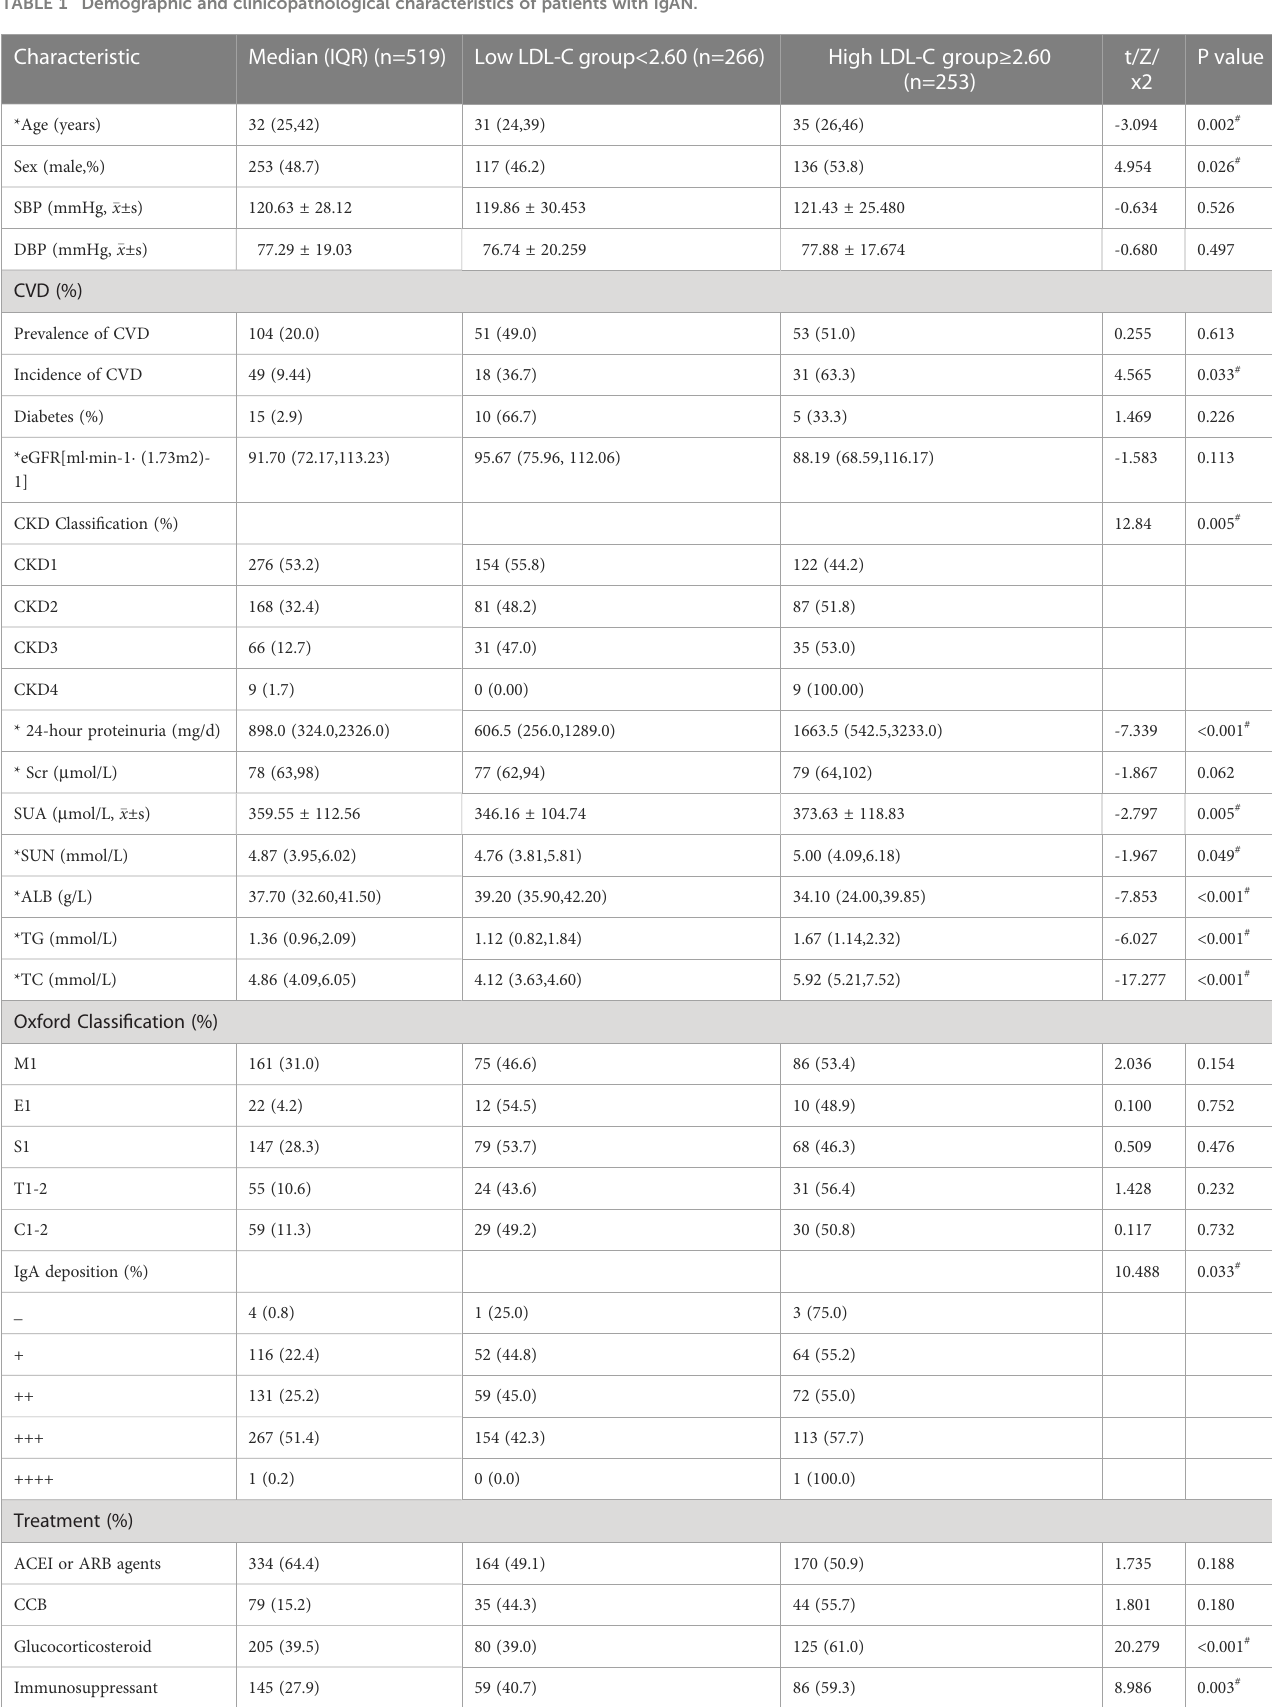
TABLE 1 Demographic and clinicopathological characteristics of patients with IgAN.